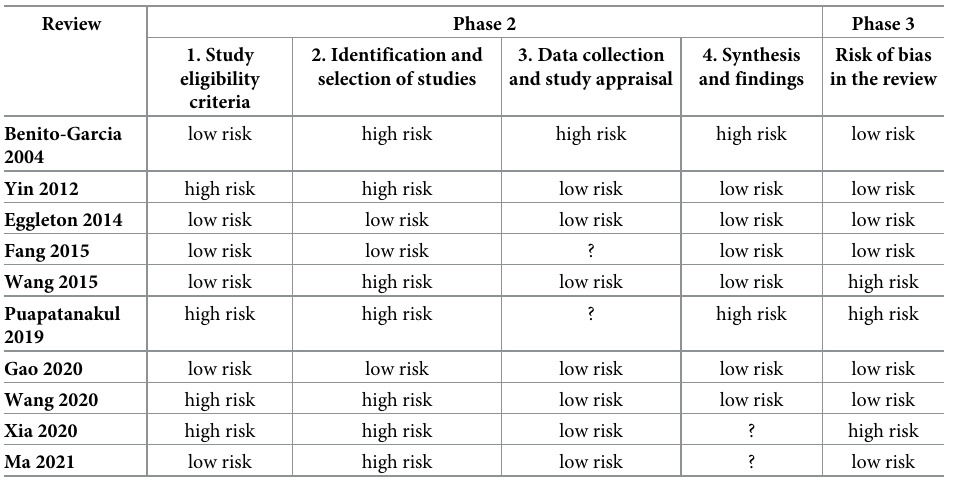
Table 3. Risk of bias assessment with ROBIS